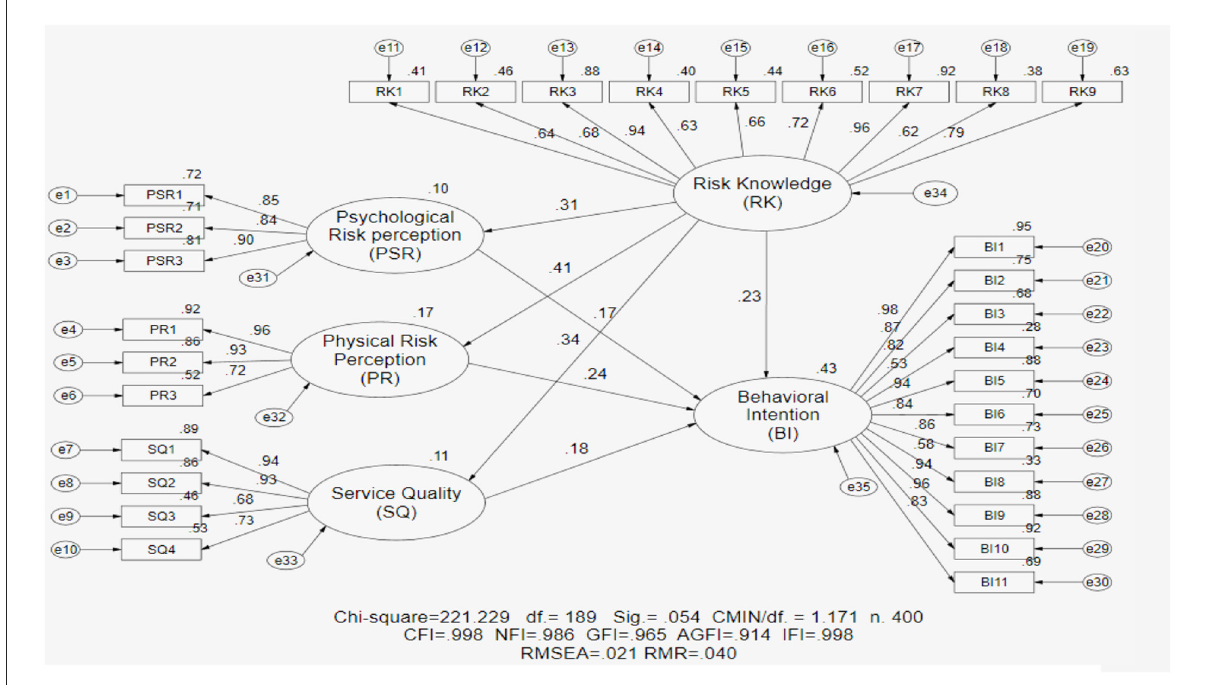
FIGURE6 Structural equation modeling analysis for risk knowledge pathways to behavioral intention of air travel risk perception during COVID-19.